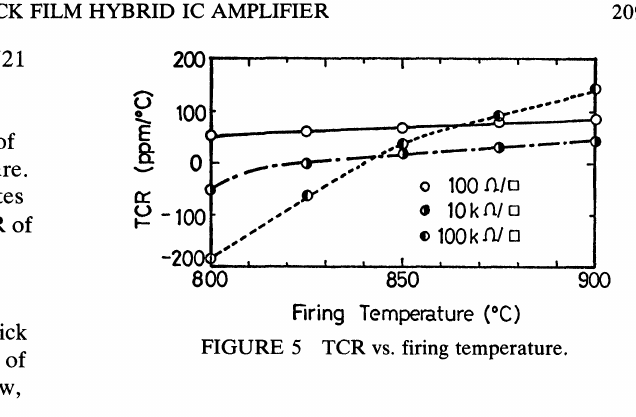
FIGURE 5 TCR vs. firing temperature.